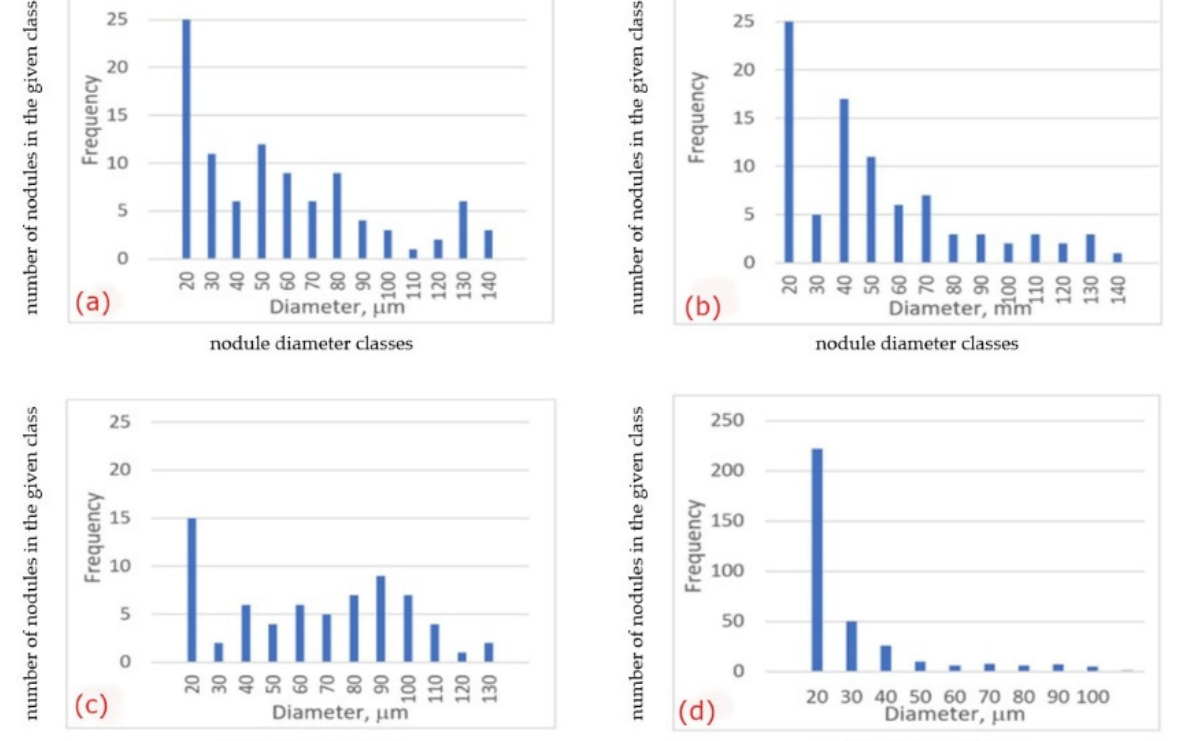
Figure 9. Distribution of the ECD of the graphite nodules in the examined castings; ( a ) Casting No. 1 (acidic molding sand No. 1), ( b ) Casting No. 2 (acidic molding sand No. 2), ( c ) Casting No. 3 (alkyd molding sand No. 3), ( d ) Casting No. 4 (alkaline molding sand No. 4).